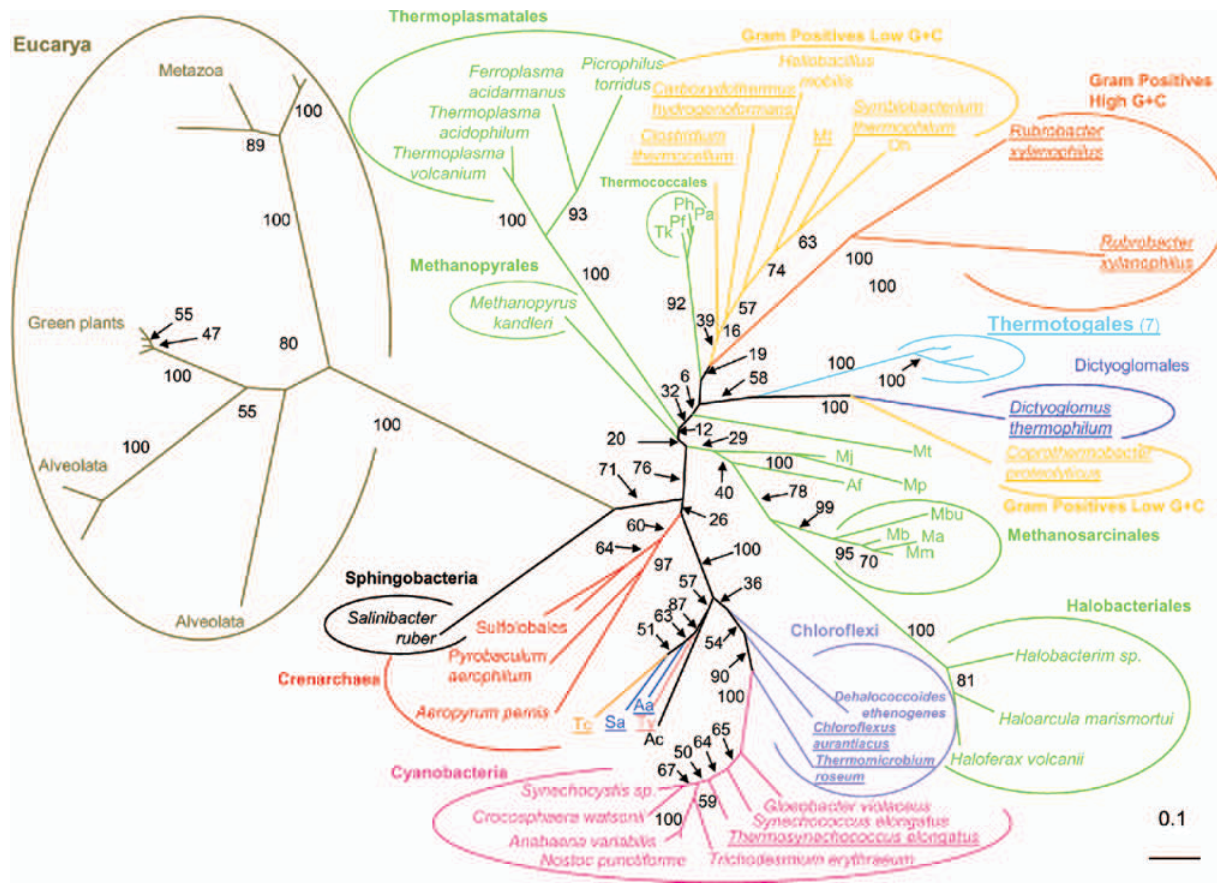
Appendix 4. Maximum likelihood unrooted phylogenetic tree of the adenosylhomocysteinase sahH (Figure 1). The tree was calculated by PHYML (JTT model, gamma correction(eightdiscreteclasses), an estimatedalpha parameterand an estimationof the proportionof